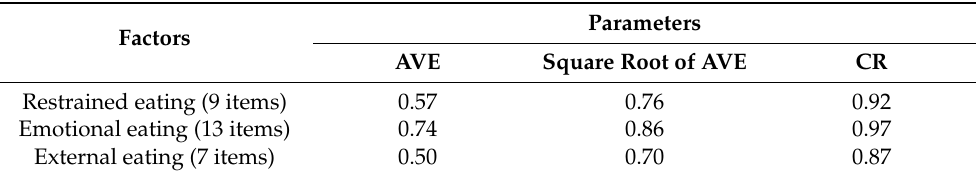
Table 3. Validity and reliability of the final DEBQ model.